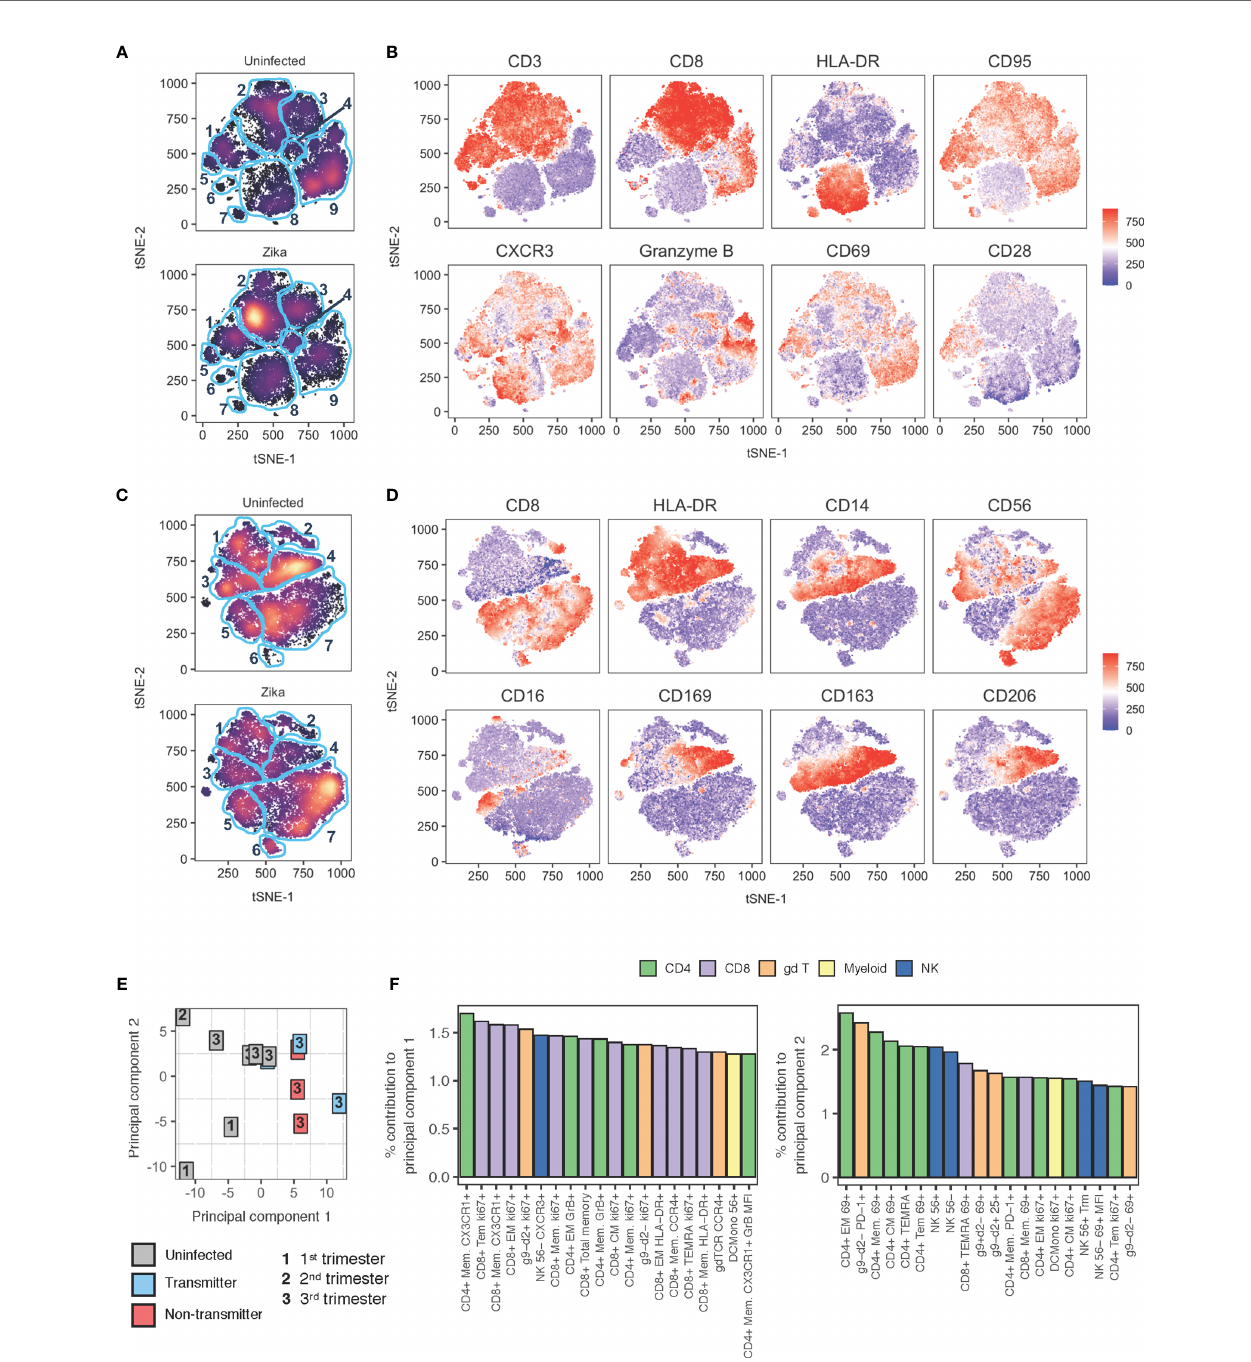
FIGURE 13 | tSNE and PCA analysis of decidual leukocytes of uninfected and ZIKV-infected rhesus macaques. (A) tSNE plot representing an equal number of CD45+/live/single cells/leukocytes cells from decidua of rhesus macaques experiencing a normal pregnancy (n = 9) or after ZIKV infection (n = 8). The 28-color adaptive panel was used to generate this plot. Blue gates were manually drawn based on clustering patterns. (B) Individual MFI gradients of eight markers on the tSNE map. Red coloring represents high MFI and blue coloring represents low MFI. (C) tSNE plot representing an equal number of CD45+/live/single cells/CD3-/ CD20- cells from decidua of rhesus macaques experiencing a normal pregnancy (n = 8) or after ZIKV infection (n = 7). The 18-color innate panel was used to generate this plot. Blue gates were manually drawn based on clustering patterns. (D) Individual MFI gradients of eight markers on the tSNE map. Red coloring represents high MFI and blue coloring represents low MFI. (E) PCA plot of decidual leukocytes of uninfected and ZIKV-infected dams. (F) The top 20 contributing variables to principal component 1 (left) and principal component 2 (right) are shown and color coded according to major cell populations, CD4+ T (green), CD8+ T (purple), gd T (orange), myeloid CD20-HLA-DR+ (yellow), and NK cells